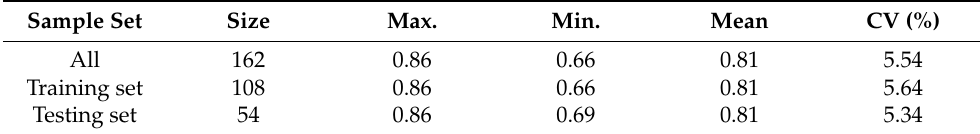
Figure 1. Technology roadmap. Table 2. Fv/Fm statistical characteristics of the different sample